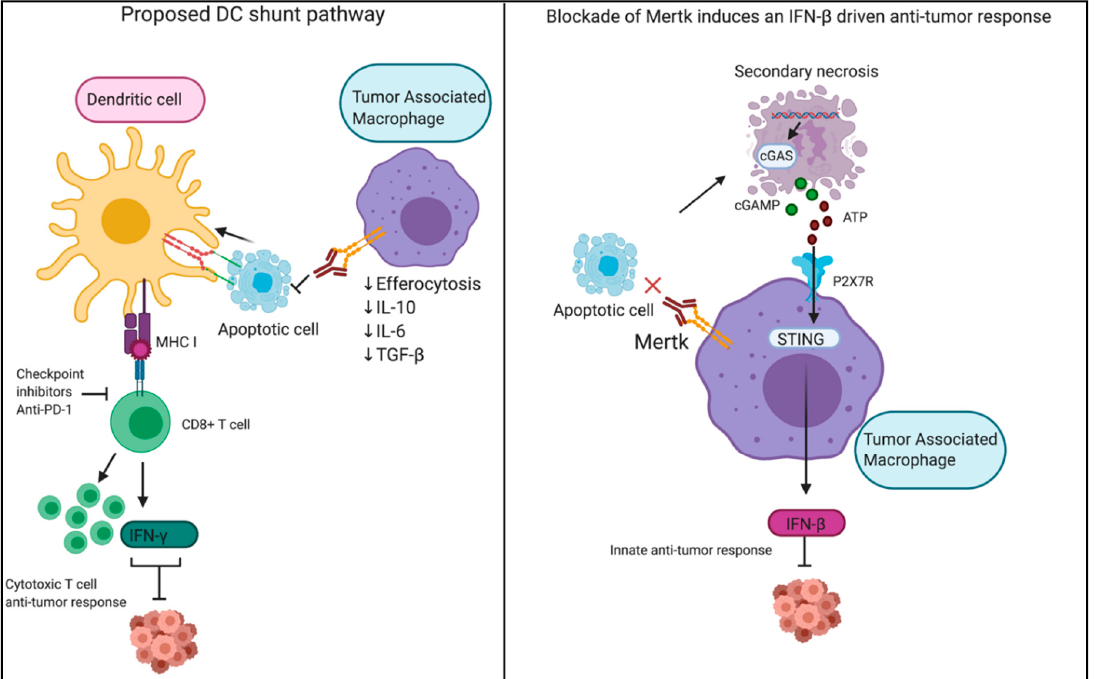
Figure 4. Inhibition of the e ff erocytosis receptor Mertk drives anti-tumor responses. In the right panel, the mechanism described by studies done by Zhou et al. is depicted wherein the blockade of Mertk